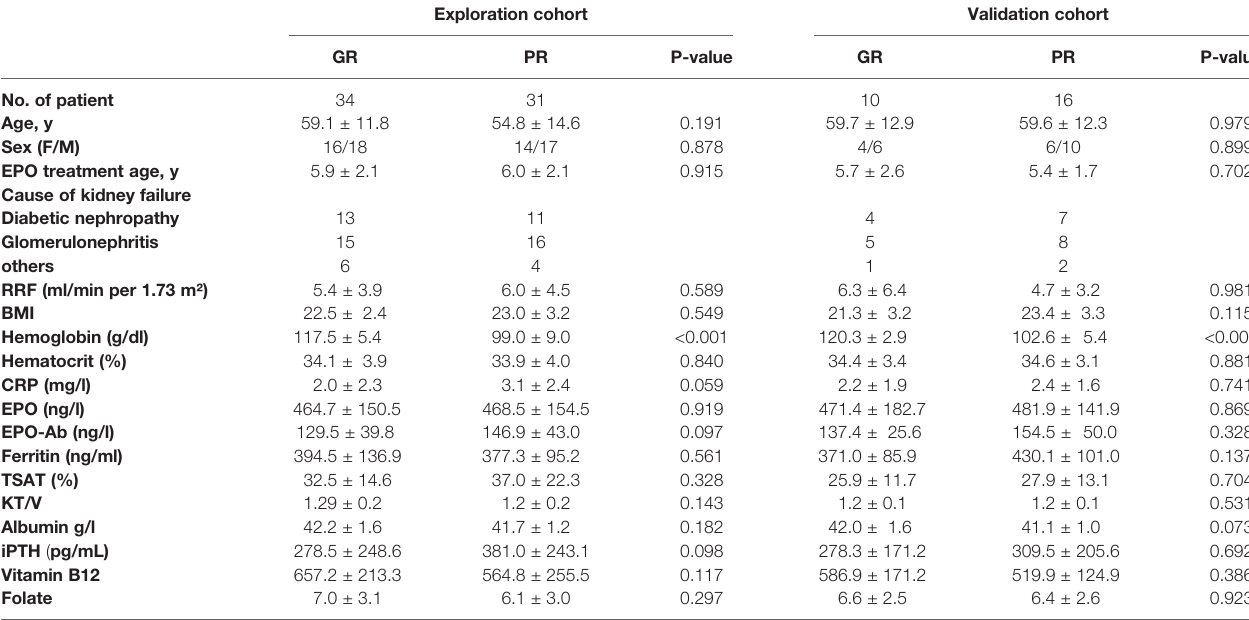
TABLE 1 | Summary of clinical